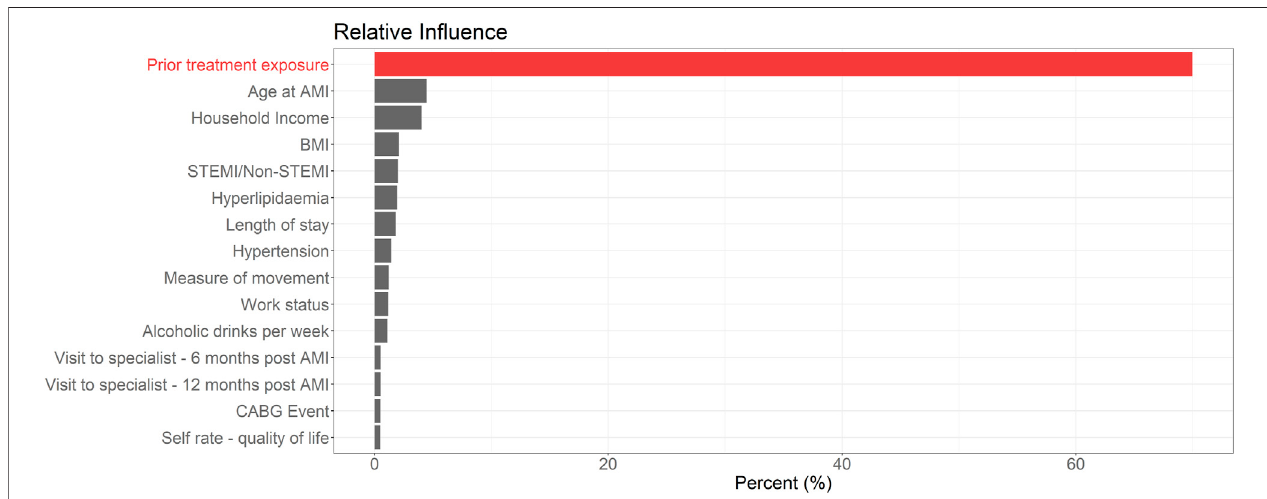
FIGURE 1 | Top 15 variables when ranked via relative in fl uence from boosted regression tree models for medication adherence 12 months post AMI.